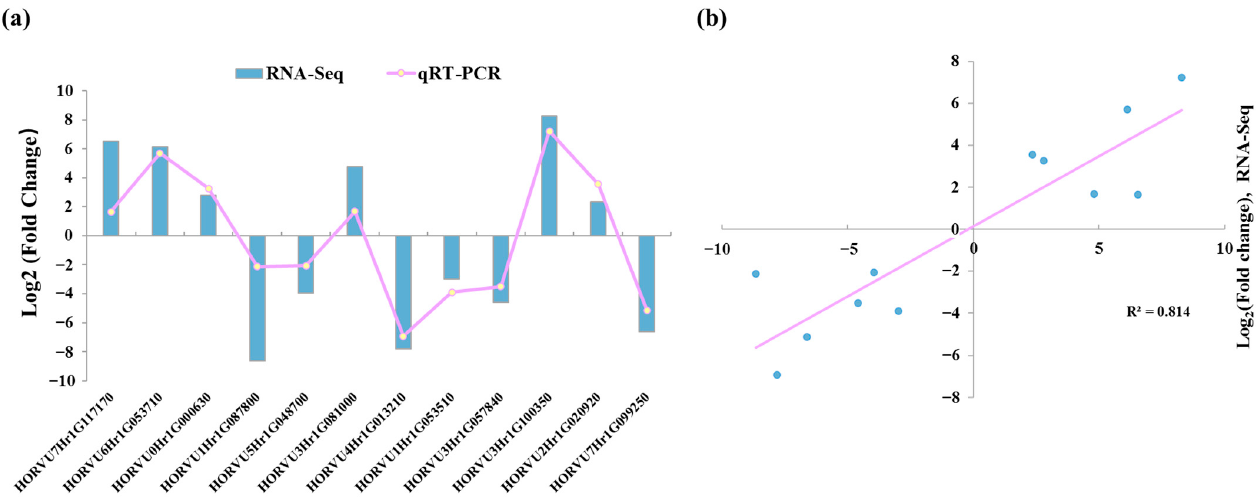
Figure 4. qRT-PCR analysis and the correlation between the results of RNA-Seq and qRT-PCR. ( a ) The relative expression level was calculated using the 2 −ΔΔ Ct method with Actin as a housekeeping gene. ( b ) The correlation between the Log 2 (Fold Change) of twelve DEGs of RNA-Seq ( x axis) and qRT-PCR ( y axis).